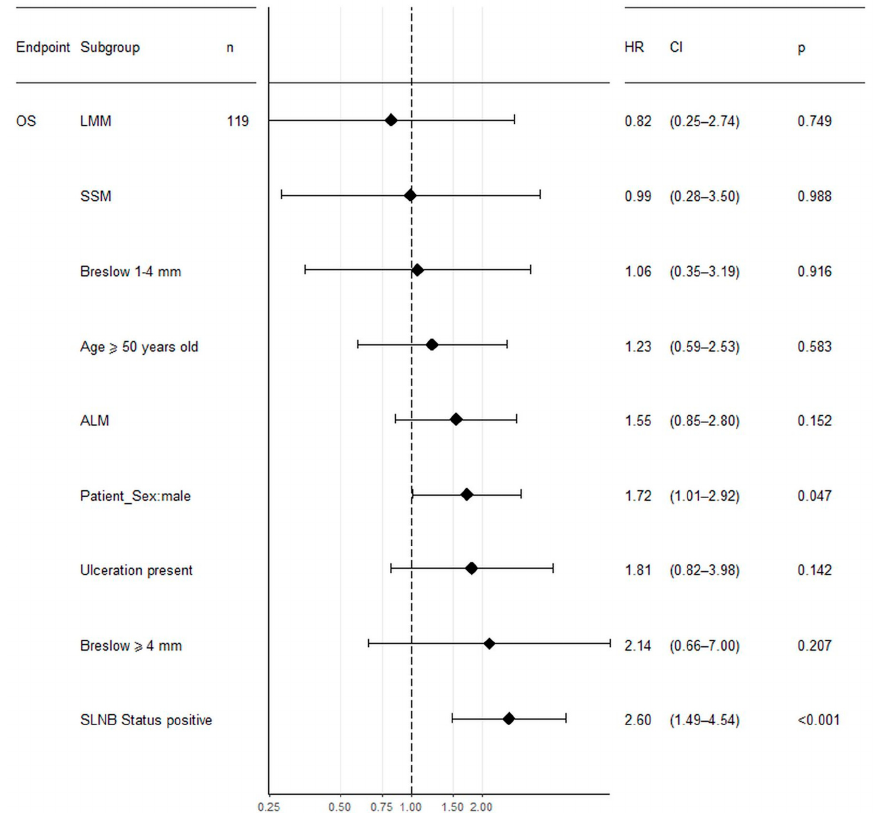
Figure 5. Forest plot showing the association between clinicopathological features and OS analyzed by multivariate analysis in HFM patients. Legend: SLNB—sentinel lymph node biopsy, NM—nodular melanoma, SSM—superficial spreading melanoma, ALM—acral lentiginous melanoma, LMM—lentigo malignant melanoma, CI—confidence intervals, HR—hazard radio, p — p -value, OS—overall survival.